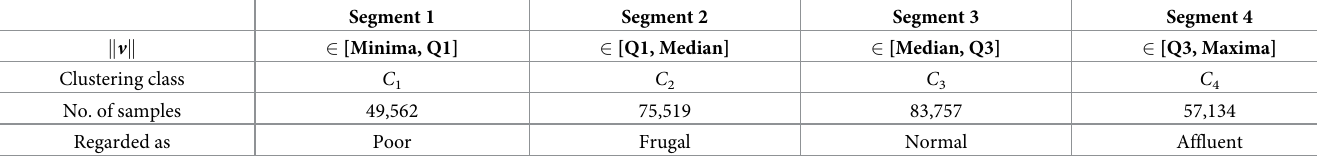
Table 2. The definition of the 4 clustering classes by the quantile data segmentation.